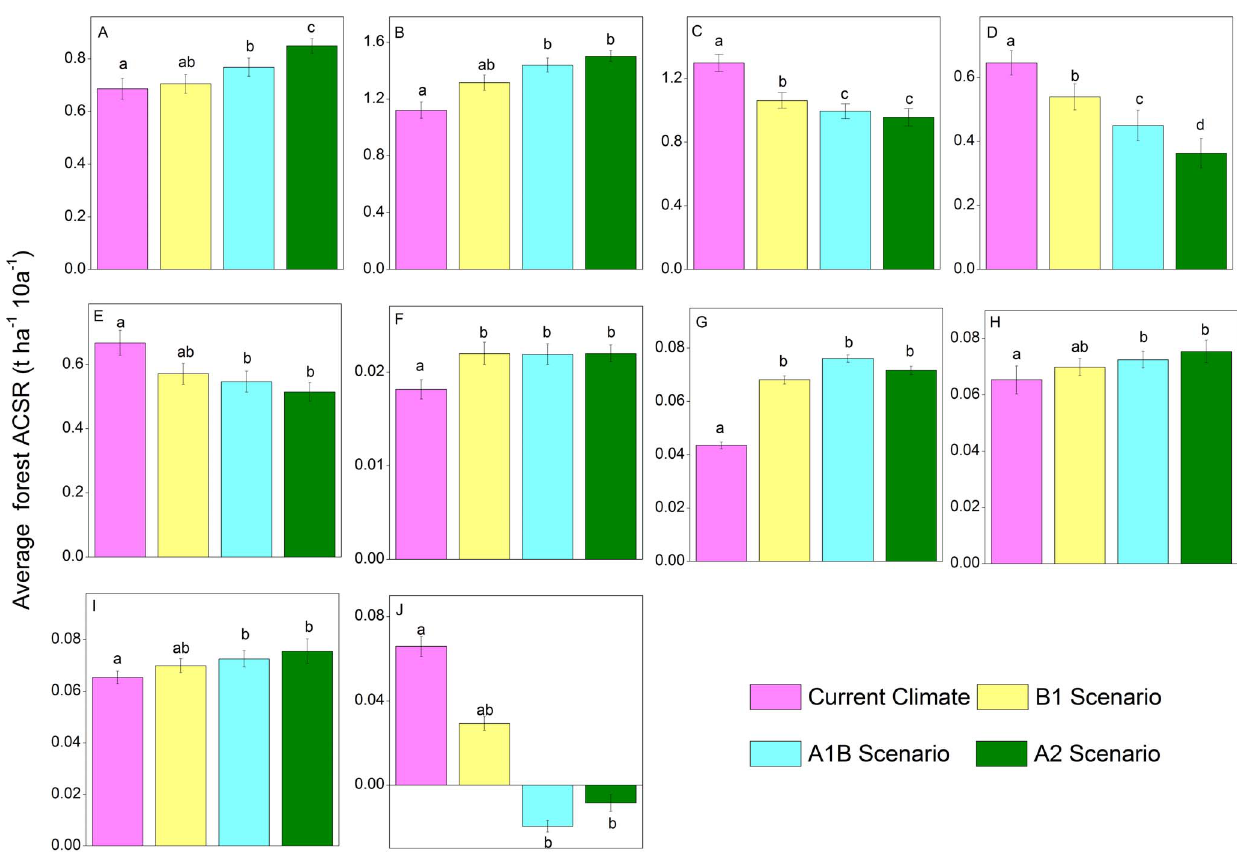
Figure 6. Results of multiple comparisons of the influences on species aboveground carbon sequestration rate. A: Korean pine in 2060–2100, B: Korean pine in 2160–2200, C: Spruce in 21260–2200, D: Khingan fir in 2160–2200, E: Larch in 2160–2200, F: Amur cork in 2060–2100, G: Amur cork in 2160–2200, H: Mongolia oak in 2160–2200, I: Black birch in 2060–2100, and J: Black birch in 2160–2200.